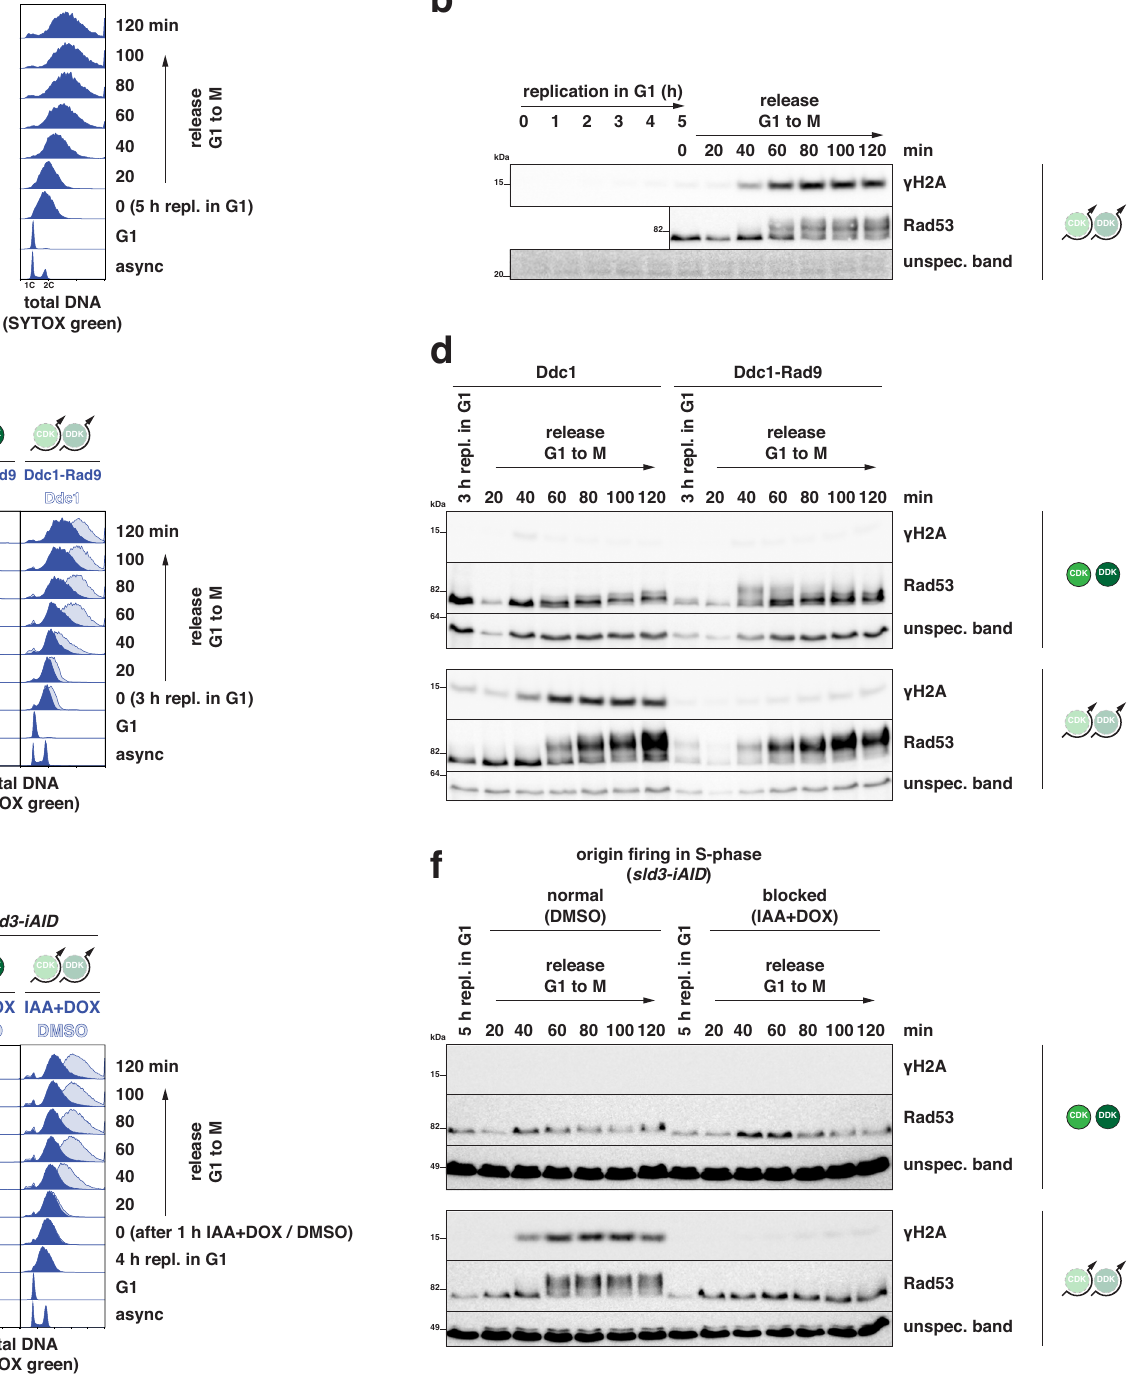
Fig. 4 | Unscheduled G1 replication induces DNA damage upon S-phase repli- cation. a , b High levels of DNA damage and checkpoint activation occur late in the subsequentS-phase. Totest the consequencesofunscheduledG1 replication, cells were released from G1 arrest after 5h of G1 replication (CDK/DDK bypass) into the cell cycle (M phase arrest, nocodazole) and followed for indicated times. a SYTOX green-stained total DNA content as measured by fl ow cytometry at the indicated timepointsshowingS-phasereplicationat20 – 40minafterrelease. b Westernblots detecting levelsof γ H2A and Rad53, forwhich phosphorylated forms are visibleby gel shift, at the indicated timepoints show strong induction of DNA damage from 60min after release. Data are representative of n =2 biological replicates. c , d A hyper-sensitized DNA damage checkpoint restricts G1 replication and prevents DNAdamageinductionafterrelease.Experimentasin( a , b )withstrainsexpressing